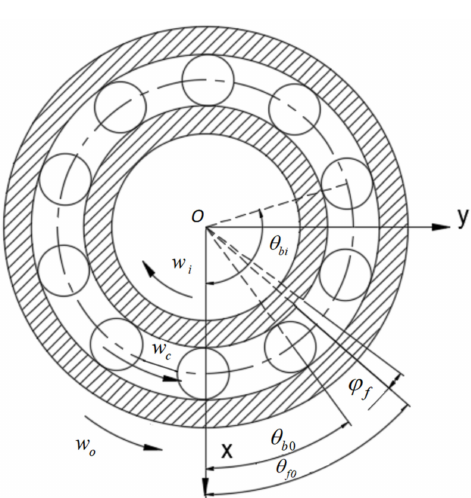
Figure 6. Roller and defect angular position of IR